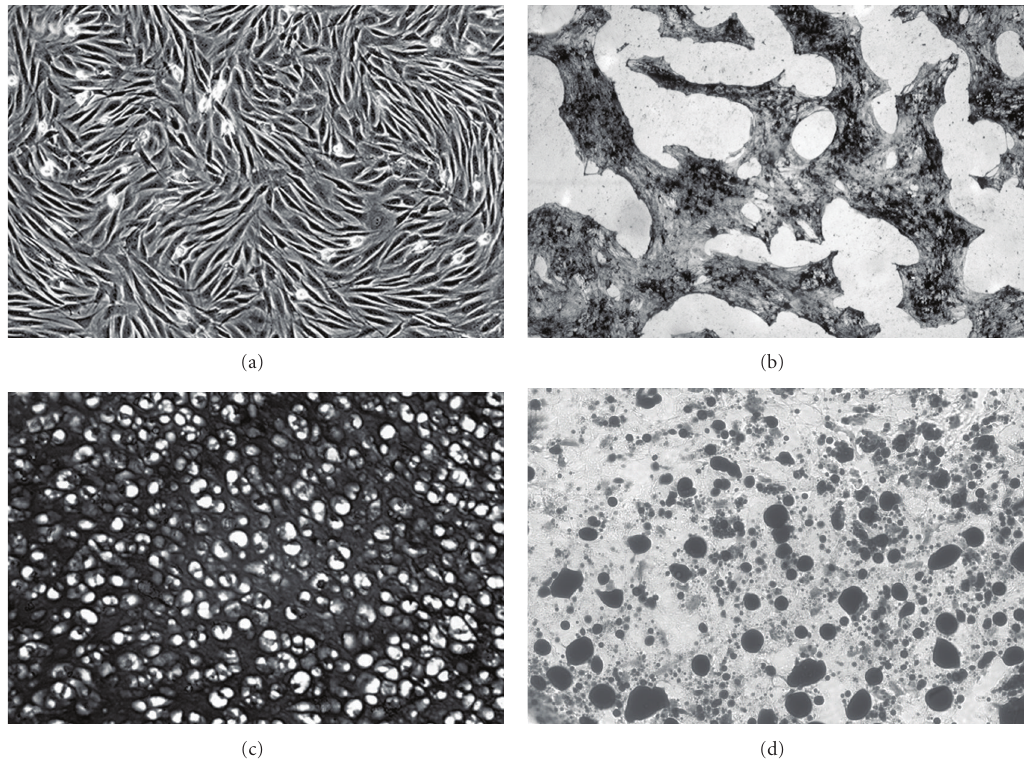
Figure 2: Functional characterization of hMSCs. Human MSCs (a) in culture, (b) after 4 weeks in osteogenic conditions (von Kossa staining), (c) after 3 weeks in chondrogenic conditions (toluidine blue staining), and (d) after 3 weeks in adipogenic conditions (oil-red O staining).